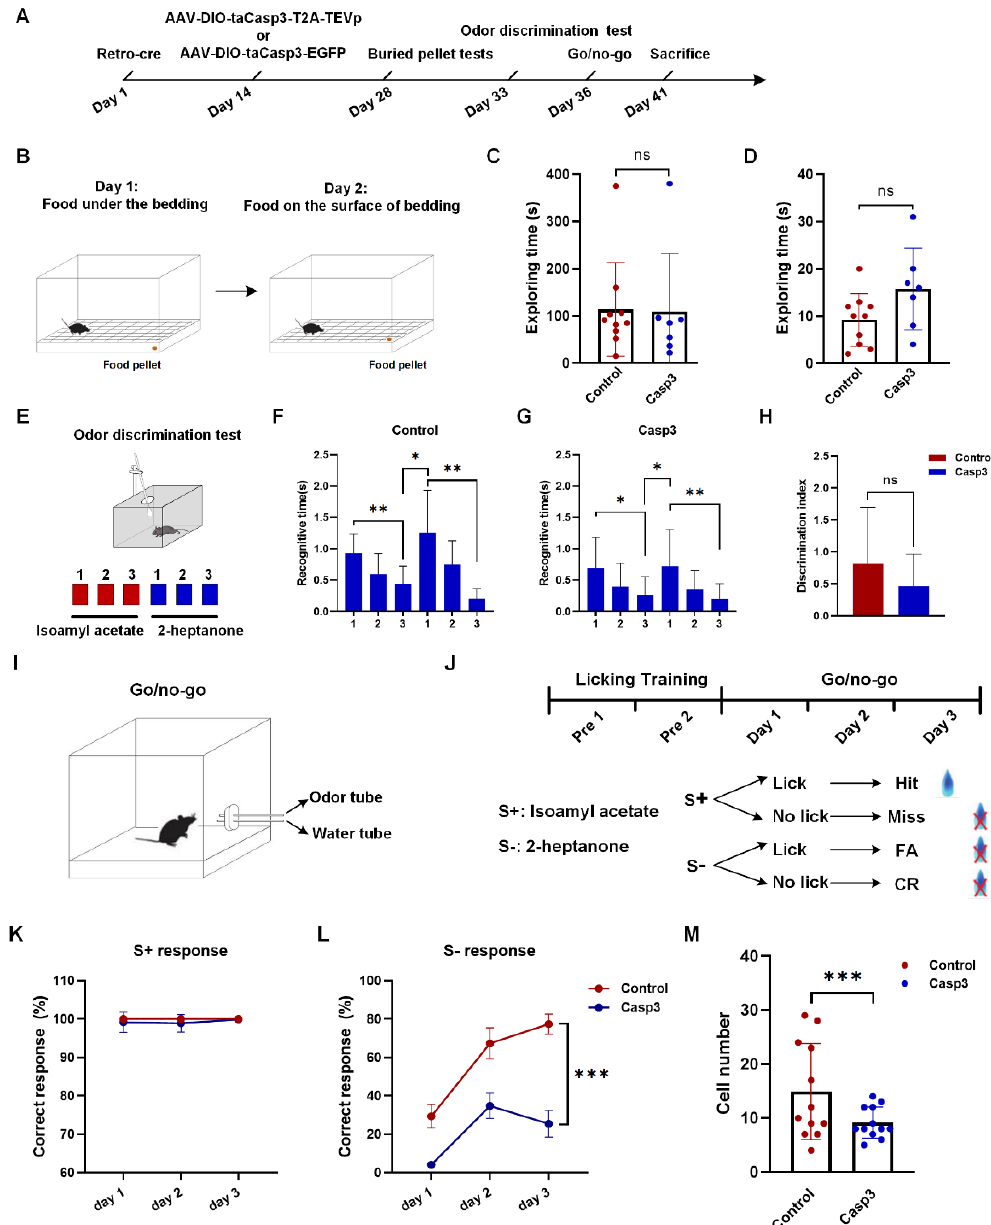
Figure 6. Selective depletion of cholinergic neurons innervating dHIP impaired correct performance of go/no-go olfactory discrimination task. ( A ) Experimental timeline of behavioral tests for selective depletion of cholinergic neurons innervating dHIP affecting olfaction and olfactory learning and memory. ( B ) Diagram of buried pellet tests. Food under the bedding (left), and food on the surface of the bedding (right). ( C , D ) Exploring the time of mice in food under the bedding phase and food on the surface of the bedding phase, respectively. ( E ) Diagram of odor discrimination test. ( F , G ) Recognition time of mice in control and Casp3 groups for isoamyl acetate and 2-heptanone, respectively. ( H ) Discrimination index of mice in control and Casp3 groups. ( I , J ) Schematic and procedure of go/no-go behavioral paradigm. ( K , L ) Correctness of response of mice in control and Casp3 groups for S+ and S-, respectively. n = 17, 7 mice in the control group and 10 mice in the Casp3 group. ( M ) The number of cholinergic neurons in HMSc between the control and Casp3 groups. A total of 4 mice in each group. * p < 0.05, ** p < 0.01, *** p < 0.001. ns, no significant difference.